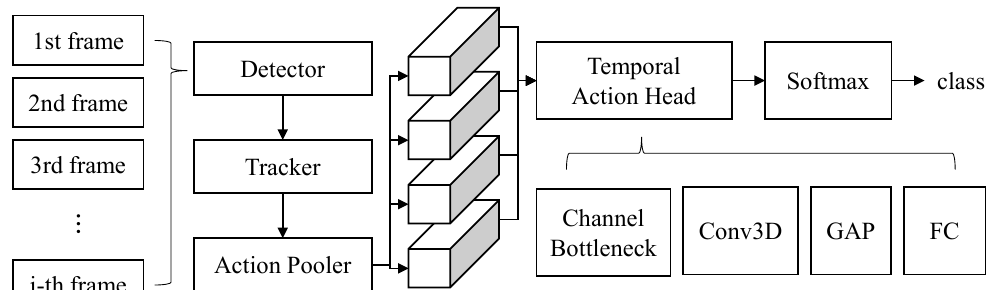
Figure 4. The proposed video action recognition architecture, in which the temporal action head network is composed of Channel Bottleneck (CB), Conv3D, GAP and FC. The CB module is composed of three 3D convolutions with 1 × 1 × 1 kernels that increase and decrease channels. The Conv3D module is 3D convolutions with 3 × 3 × 3 kernels that keep specific channels. GAP and FC mean global average pooling and fully connected layer,